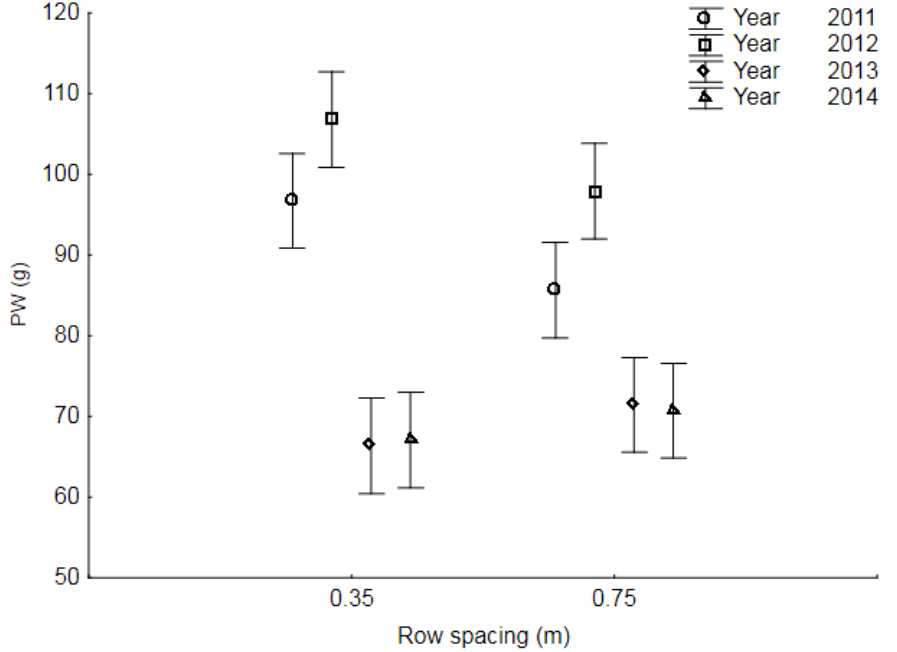
Figure 1. Plant weight (PW) for two row spacings (0.70 m and 0.35 m) at a plant density of 92,000 plants ha − 1 during the growing seasons in 2011–2014 ( p = 0.010).